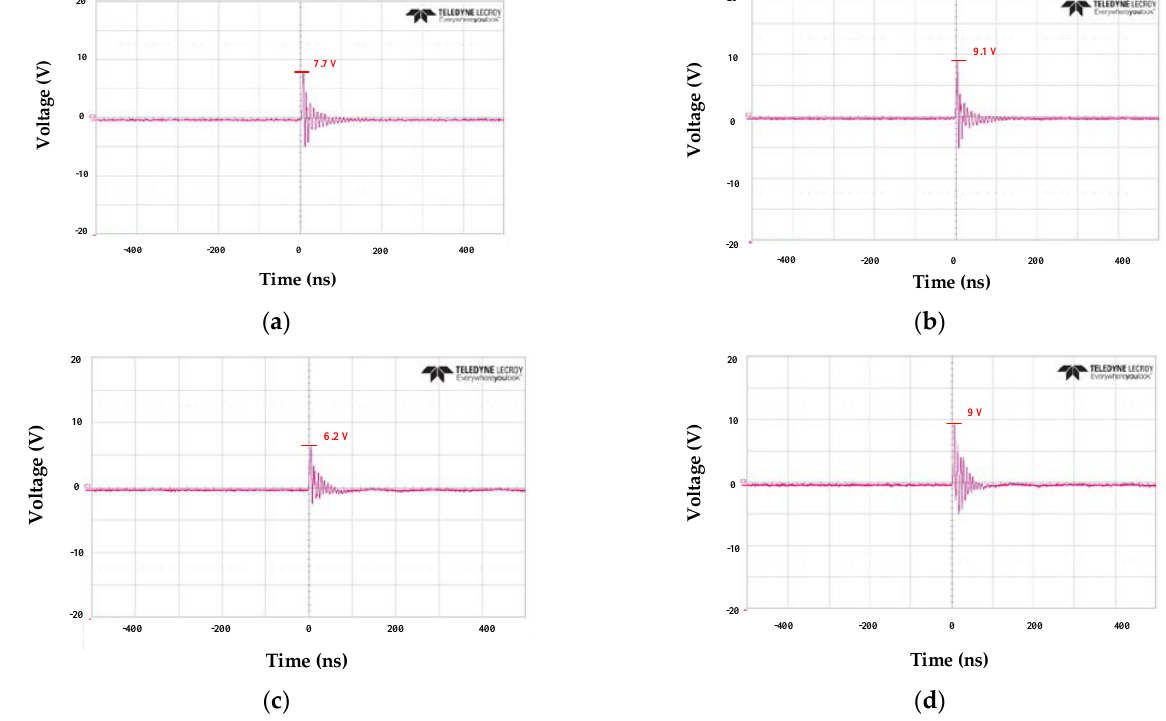
Figure 14. Measured output of a pickup coil following switch behavior: ( a ) switch-on condition at 100 V DC voltage, ( b ) switch-off condition at 100 V DC voltage, ( c ) switch-on condition at 200 V DC, and ( d ) switch-off condition at 200 V DC voltage.